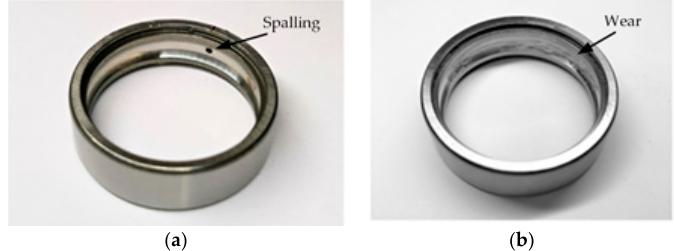
Figure 5. Experimental setup of the bearing failure bench.